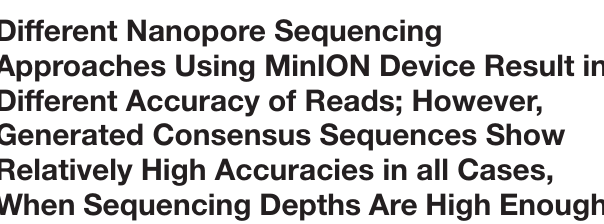
FIGURE 3 | classification. (A) Percentage of specific virus reads in trimmed and filtered complete HTS datasets. (B) Average fraction of reference covered by reads (%) at different subsample sizes. Dots represent the average value of analysis of 5 replicate subsamples. Different subsample sizes were used (10, 30, 50, 100, 200, 300, 500, 700, 900, 1,100, 1,300, 1,500 million nts–note the enlarged x-axis in the lower left part of panel 3B for a clearer view). (C) Fraction of reference covered by contigs (%) at different subsample sizes. Every bar represents the result of analysis for separate replicate subsamples. In (B,C) , gray areas designate the range